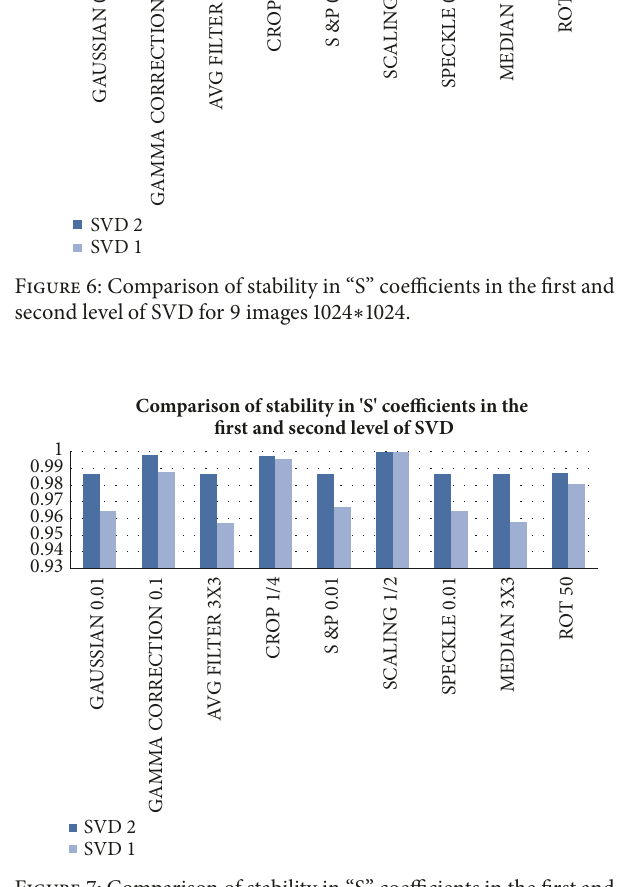
Figure 7: Comparison of stability in “S” coefficients in the first and second level of SVD for 18 images 256 ∗